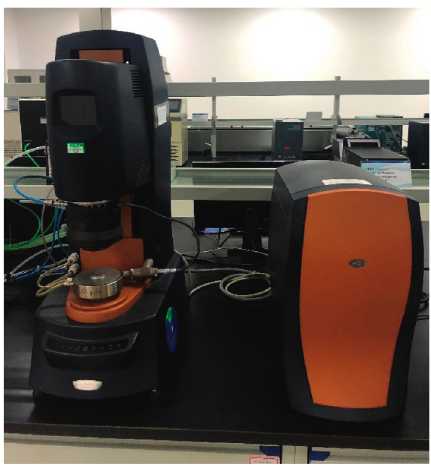
Figure 2: Kinexus ultra +rotational